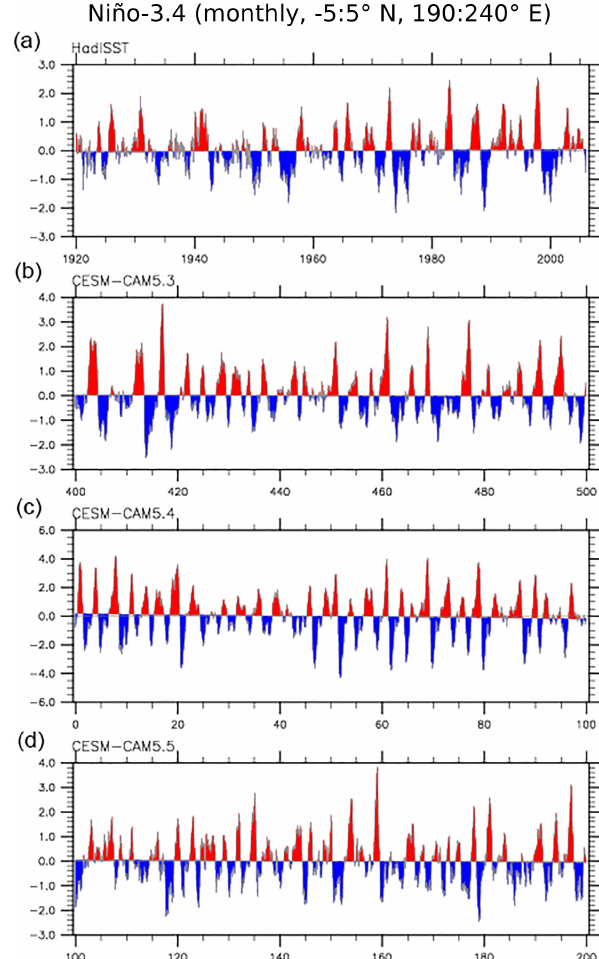
Figure 13. Niño-3.4 time series for HadISST observations (a) , CESM-CAM5.3 ( b , years 400–499), CESM-CAM5.4 ( c , years 0– 99), and CESM-CAM5.5 ( d , years